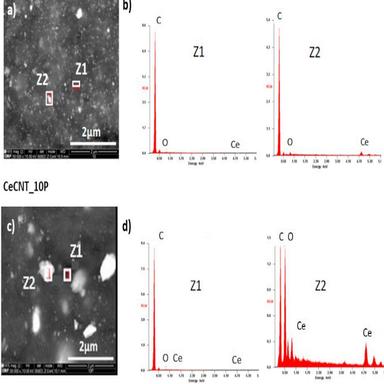
SEM images using backscattered electron detector for a) CeCNT_10E and c) CeCNT_10P and the respective EDS spectrum; b) CeCNT_10E and d) CeCNT_10P.